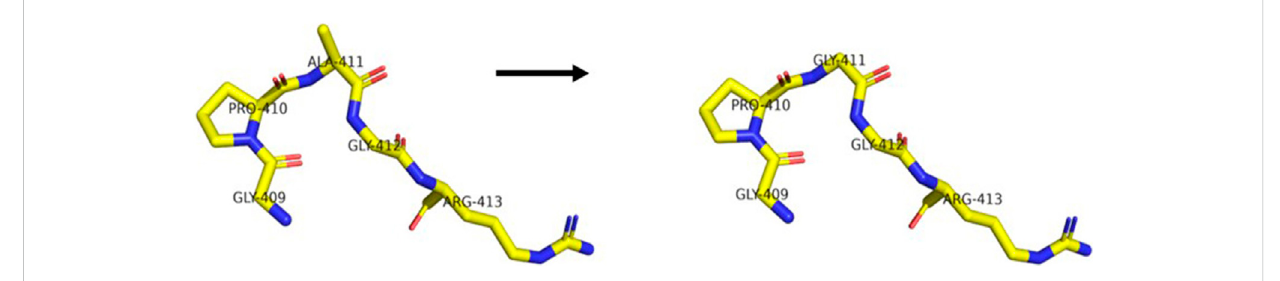
FIGURE 4 Differencebetweenthewide-typeandmutantprotein(p.G411A)of PRKCG (regionalmodel).Theleftmodelisthemutant,andtherightmodelisthe